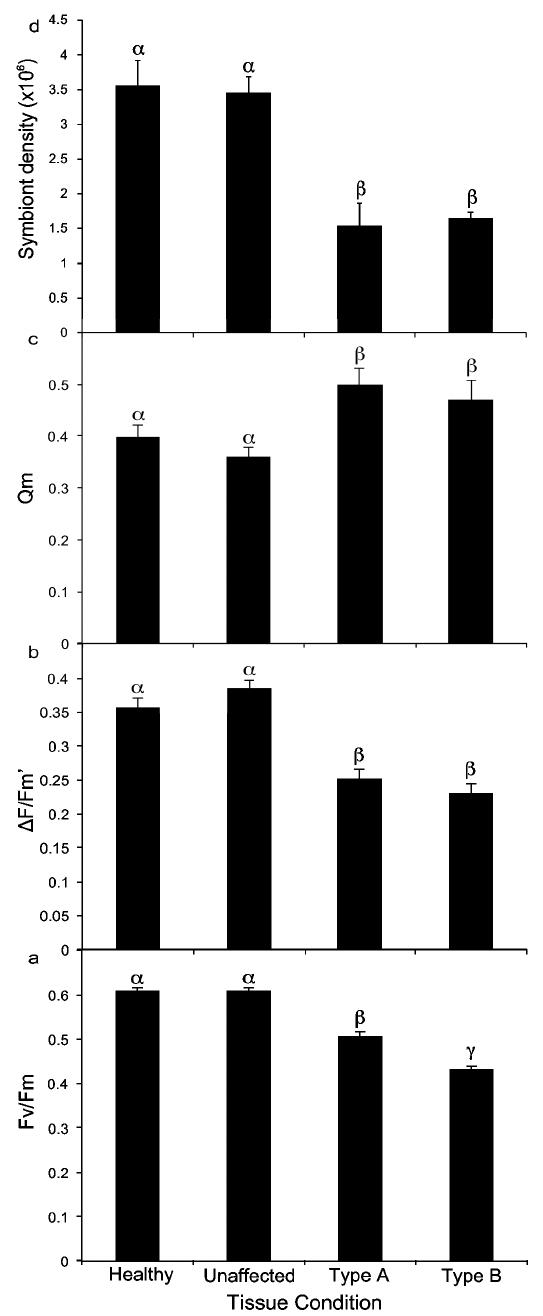
Figure 2. Comparison of photophysiological parameters among tissue conditions. Comparison of photophysiological parameters among healthy, unaffected, Type A GA, and Type B GA tissues of the coral, Montipora capitata . a Mean (± s.e.) values of maximum quantum yield (F values of effective quantum yield (ΔF/F values of pressure over photosystem II (Q symbiont density among the examined tissue conditions in the coral, Montipora capitata . α, β, and γ denote groupings identified by statistical significance (p<0.01). doi: